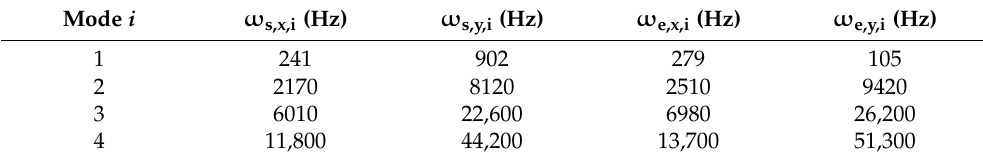
Table 1. Analytical estimations of the Eigen frequencies of the broach at the starting and ending positions in x and y